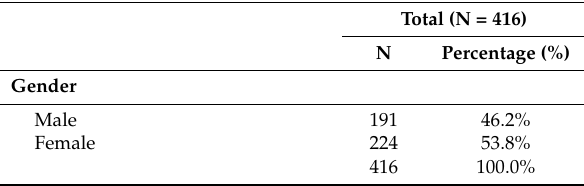
Table 1. Demographic